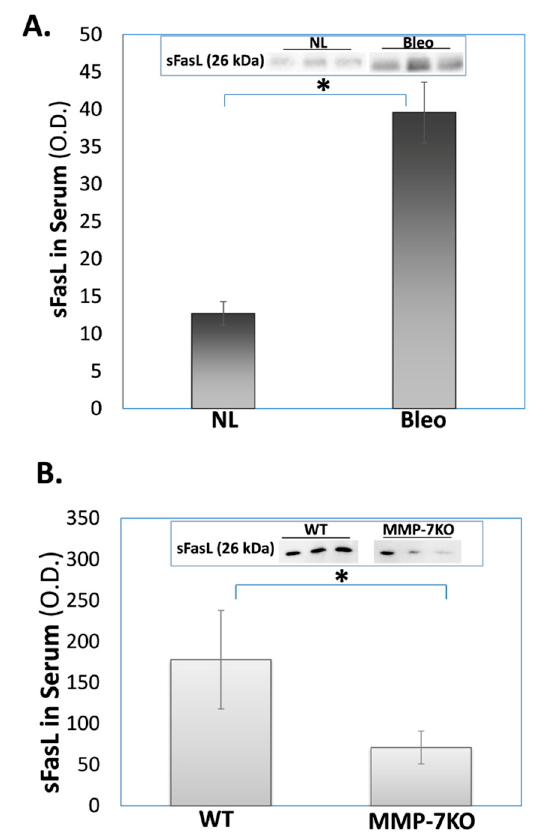
Figure 3 . sFasL is increased in the blood serum of wild type (WT), but not of MMP-7 knock-out (KO) bleomycin-treated, mice. The graphical presentation and inserts of WB with the OD analysis of sFasL assessed from equal volumes of blood serum samples (10 µ L) of day 14 of ( A ) bleomycin (Bleo) vs. saline (NL)-treated WT mice, and ( B ) bleomycin-treated WT vs. MMP-7 KO mice. Mean ± standard deviation; n = 4; * p < 0.05.